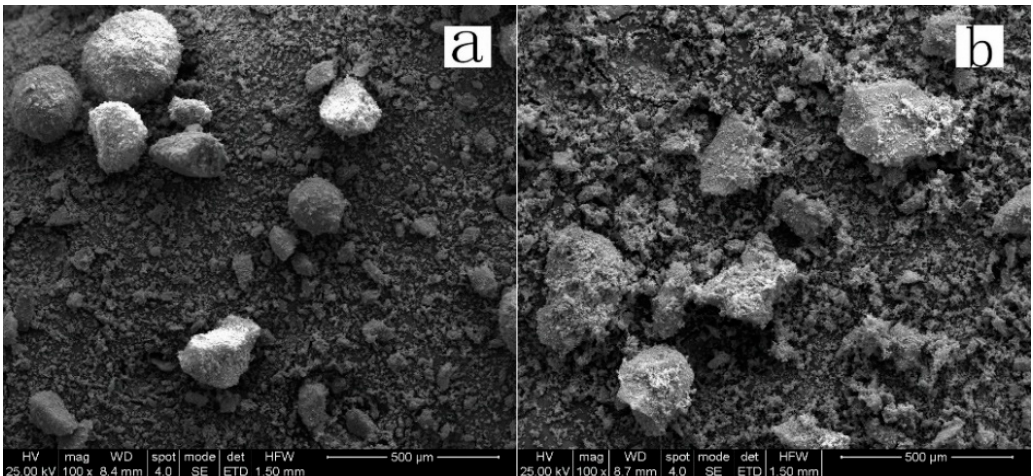
Figure 15. SEM images of residues ( a ) leaching temperature of 150 °C; ( b ) leaching temperature of 160 °C.